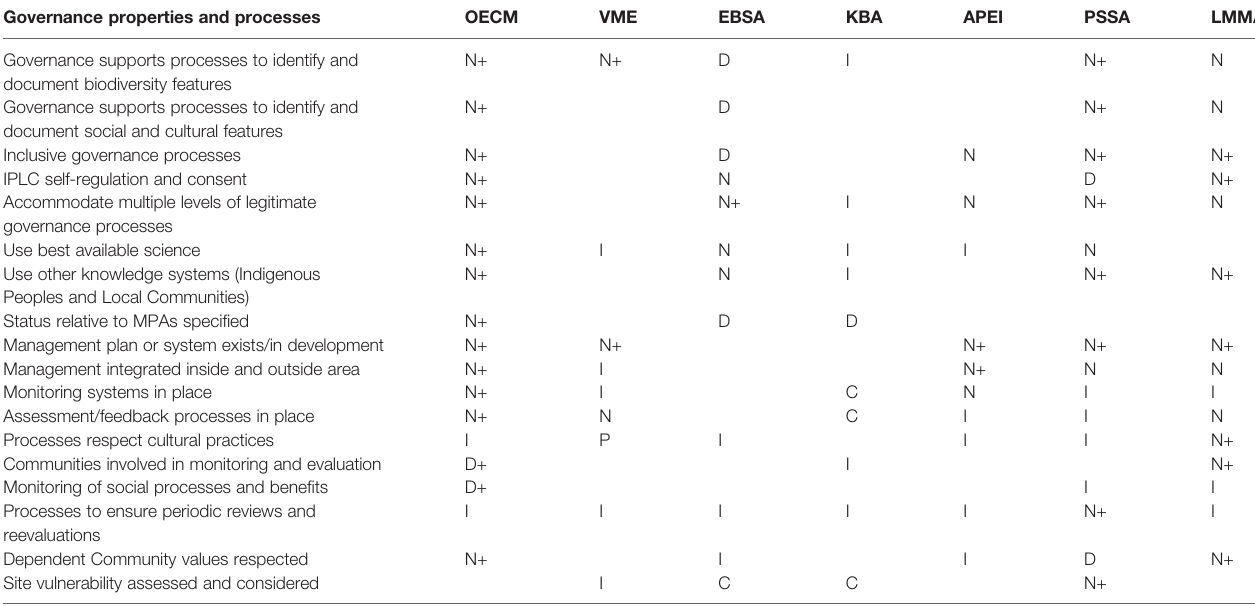
TABLE 4 | Governance properties and processes tabulated by explicitness and clarity of inclusion in the foundation documents for each acronym. Governance properties and